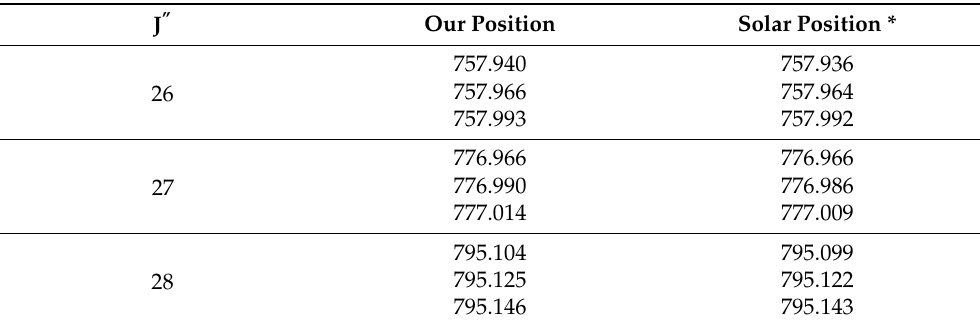
Figure 16. Deconvolution of an NH radical triplet line ( J’’ = 26, v = 0) [153]. Our observed pure rotational lines of NH radical are summarized in Table 1 below. Table 1. Overview of the laboratory observed pure rotational NH lines (in cm − 1 ).